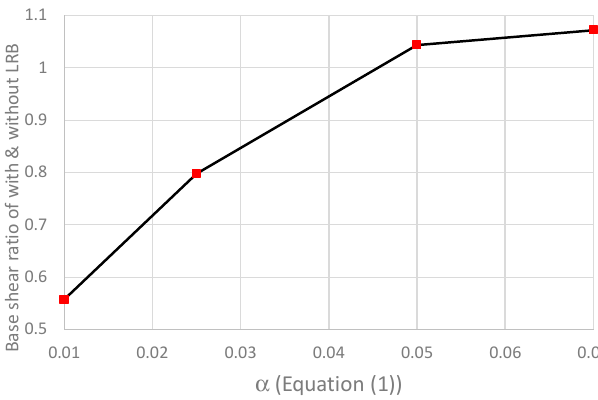
α (Equation (1)) under the PGA of 0.32 g and T